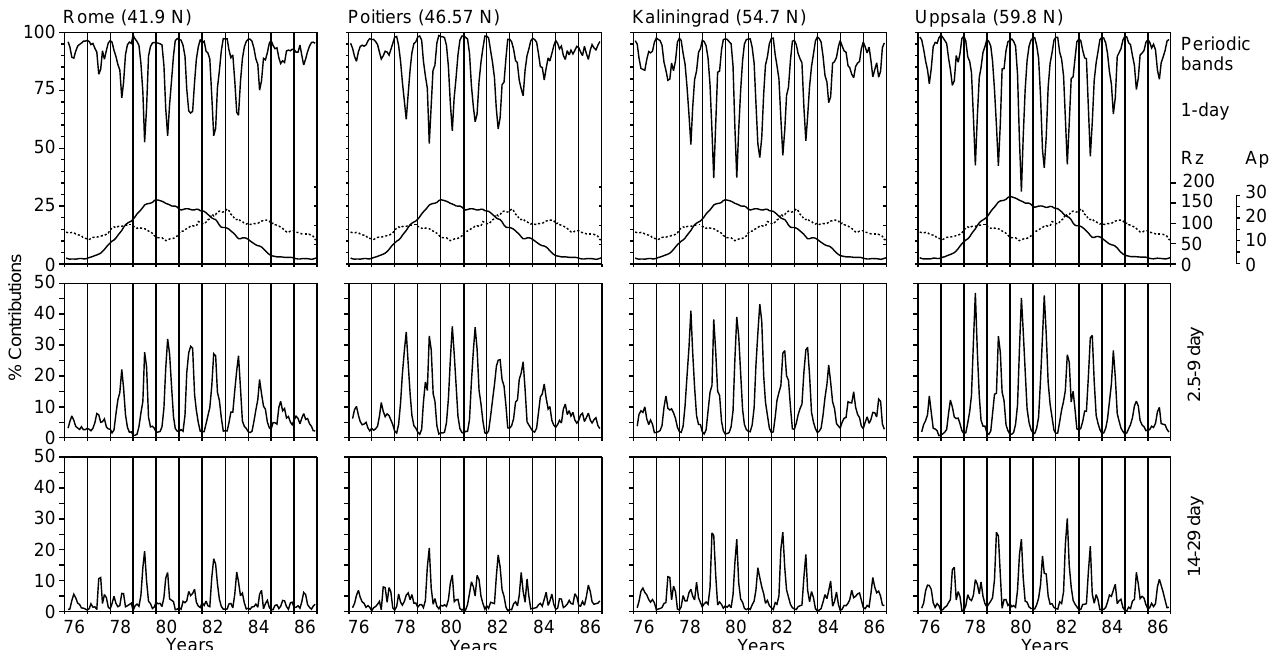
Fig. 5. Annual and solar cycle variations of the integrated percent contributions for daily variation, for periodic bands due to planetary wave activity (2.5–9 day) and solar flux variations (14–29